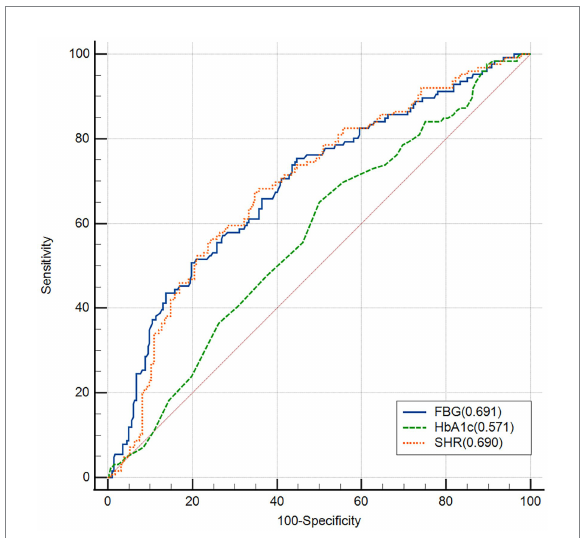
FIGURE 3 Receiver operating characteristic (ROC) analysis of fasting blood glucose (FBG), HbA1c and stress hyperglycemia ratio (SHR) for the less excellent neurological outcome. production of reactive oxygen species, proinflammatory cytokines, and lactic acid, which result in reperfusion injury (Kruyt et al., 2010). Otherwise, stress hyperglycemia leads to inflammatory